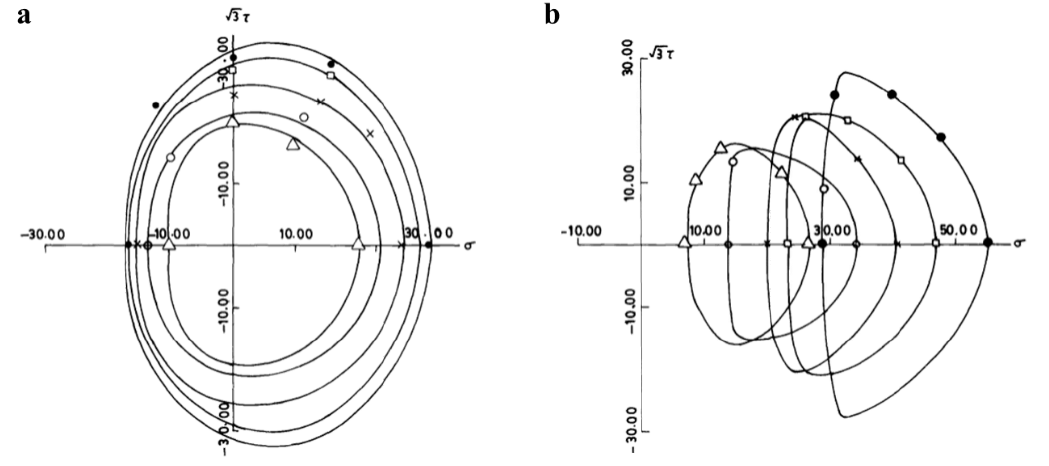
Figure 3. Yield surfaces in the plane of 𝛔 − √𝟑𝝉 obtained by Shiratori et al. [55] determined by: ( a ) the total unloading or ( b ) the partial unloading method with the pre-strains of 0%, 2%, 6%, 12%, 20%, 30% (the stress points with different pre-strain levels are marked by different symbols) and with an offset strain of 2 × 10 − 4 . Reprinted with permission from Ref. [49]. 1992, Gupta, N.K. et al.